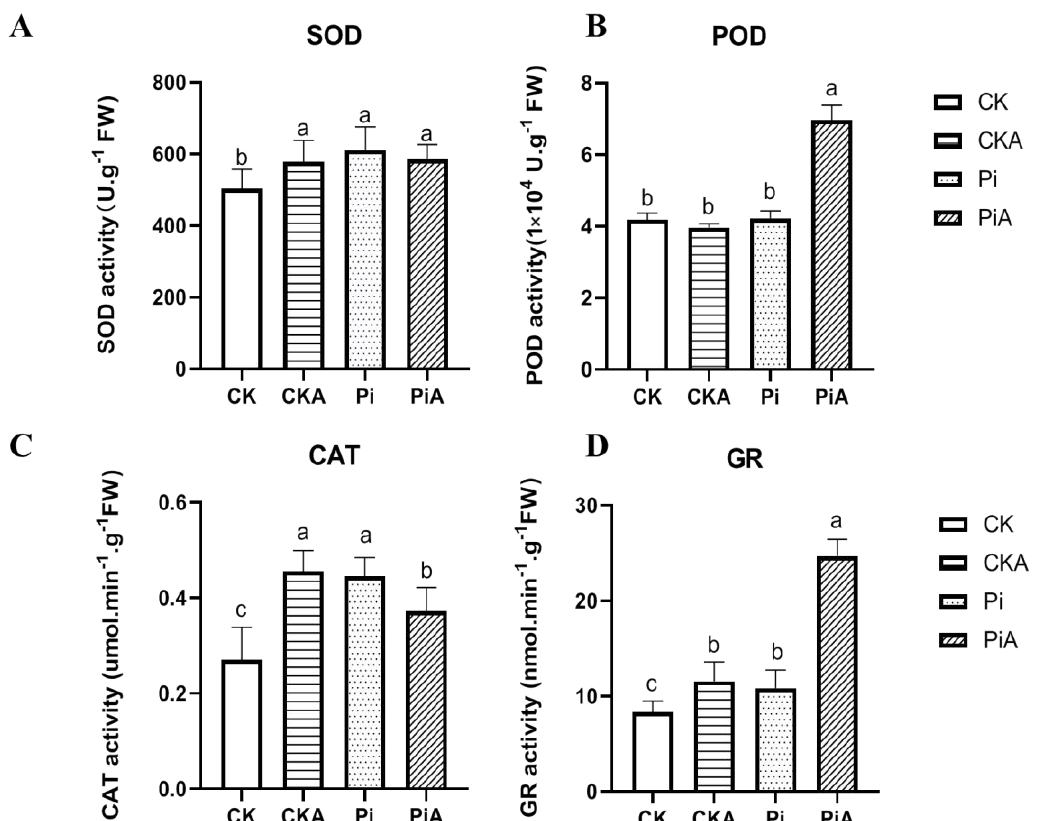
Figure 5. Effects of Piriformis indica on antioxidant enzyme activities in leaves of soybean under salt stress. The enzyme activities of SOD ( A ), POD ( B ), CAT ( C ), and GR ( D ) were detected in the leaves of non-colonized plants (CK) compared to those colonized with P. indica (Pi). CKA: control plants were treated with 200 mmol/L NaCl. PiA: inoculated soybeans were treated with 200 mmol/L NaCl. The error bars indicate the standard deviation (n = 9). The different letters above the bars indicate a significant difference ( p < 0.05).